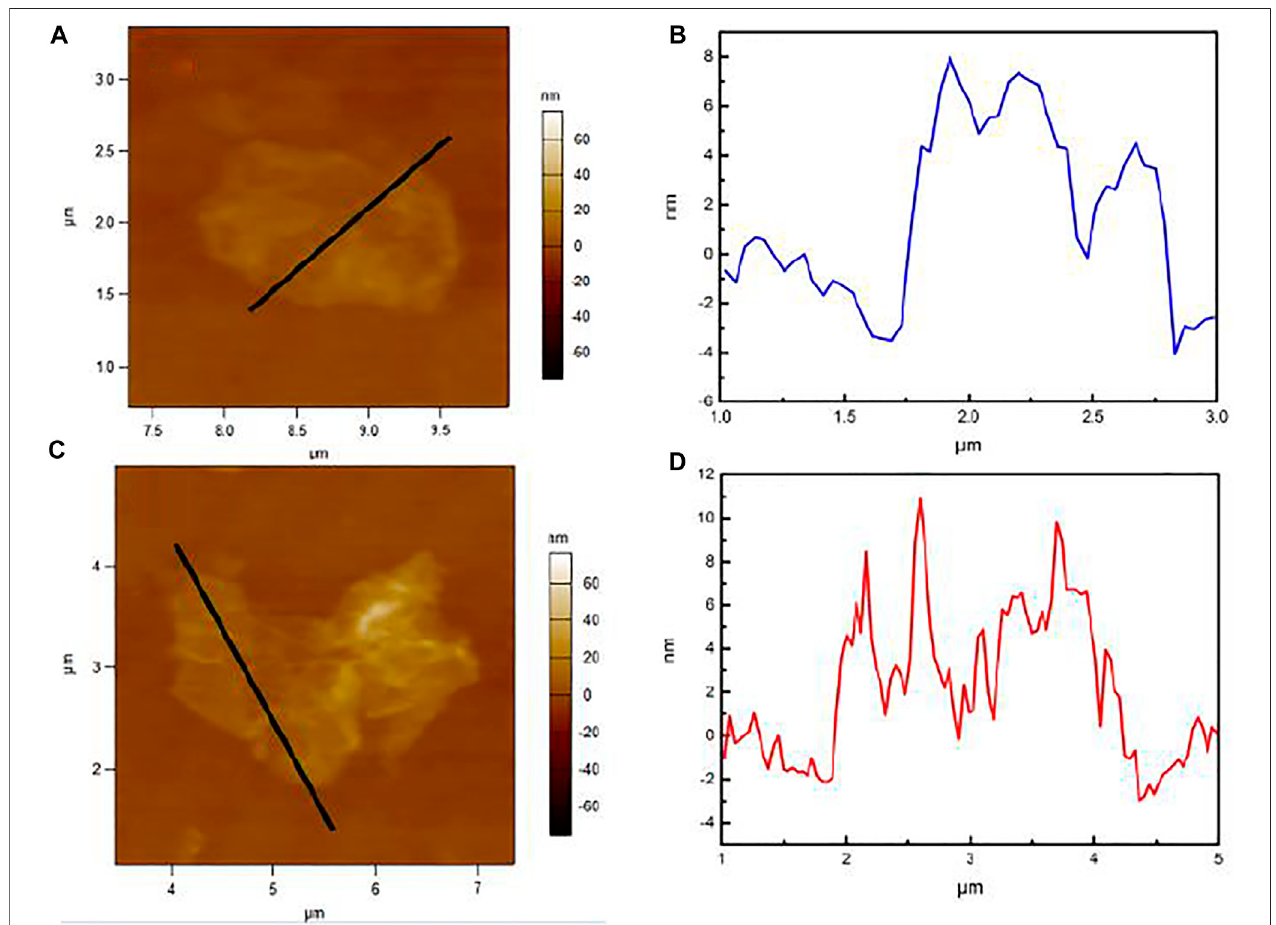
FIGURE 3 | AFM images of fi lms deposited on a silicon wafer through drop-casting: (A, B) GO; (C, D) GO-APS.